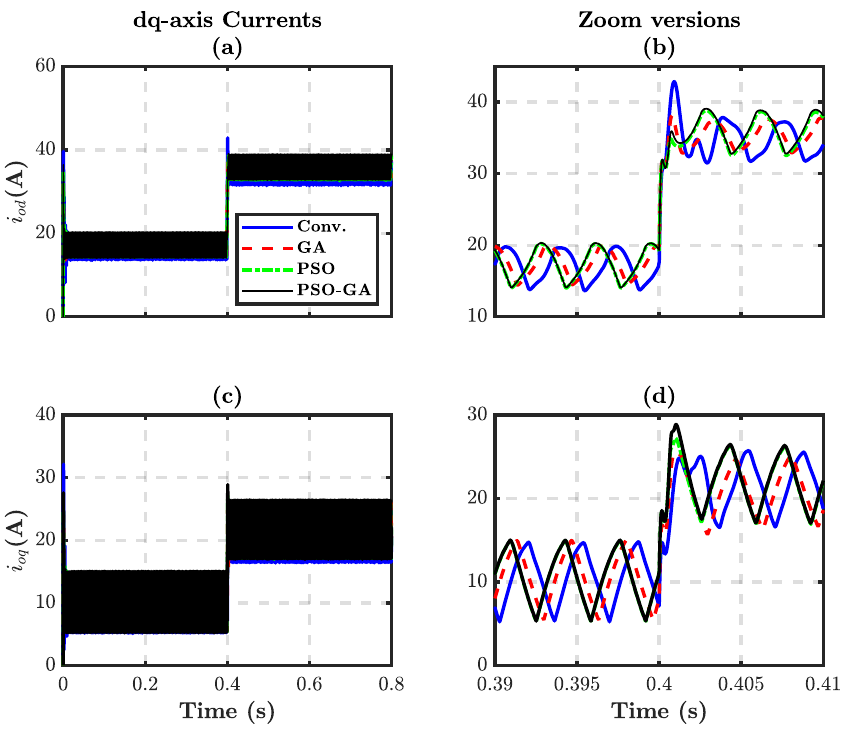
Figure 22. The dq -axis output current with different designed parameters under nonlinear load changes: ( a ) d -axis current; ( b ) d -axis current zoom version; ( c ) q -axis current; ( d ) q -axis current zoom version.